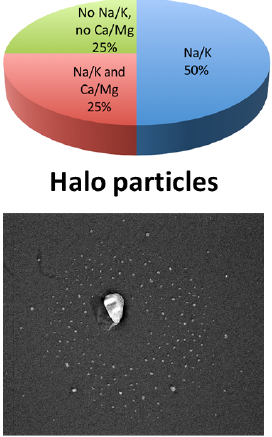
Figure 12. Fraction of HP containing the following ions: Na + /K + (blue), Na + /K + and Ca 2 + /Mg 2 + (red), and neither Na + /K + nor Ca 2 + /Mg 2 +